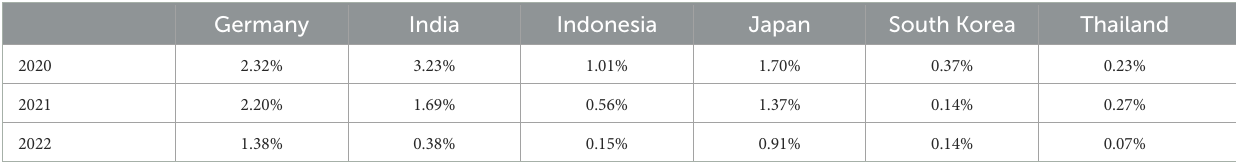
TABLE 4 COVID-19 related social media (Twitter) reaction depicted by the ratio of annually total tweet counts of “COVID-19 related tweets” vs. “all tweets.”